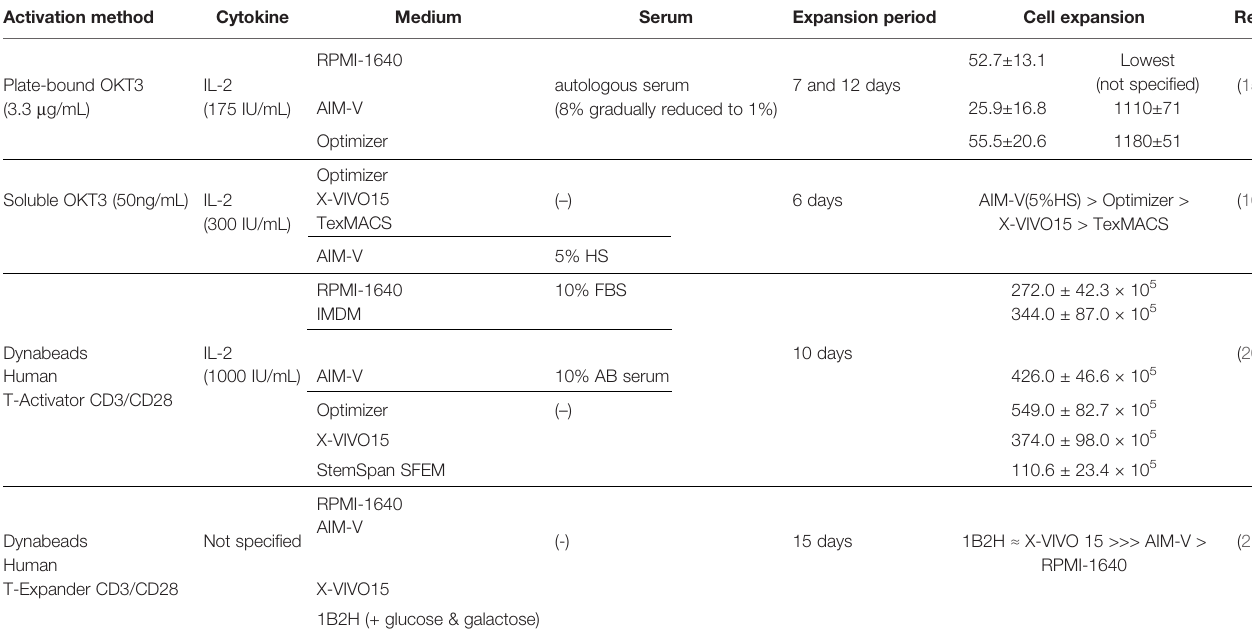
TABLE 1 | Impact of media on cell